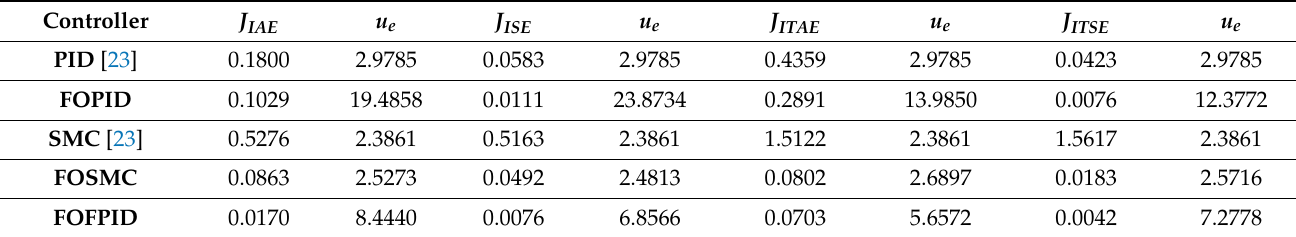
Table 6. Comparison of performance indices and control energy values for PID, FOPID, SMC, FOSMC, and FOFPID controllers under the considered